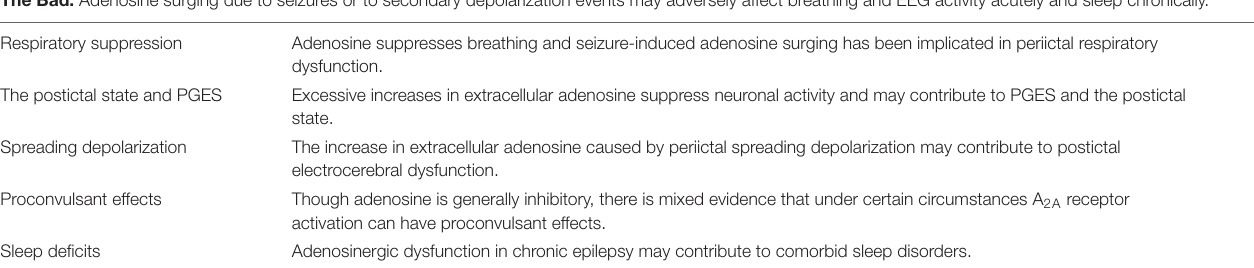
TABLE 2 | The potentially harmful effects of adenosine in the context of seizures and epilepsy. The Bad: Adenosine surging due to seizures or to secondary depolarization events may adversely affect breathing and EEG activity acutely and sleep chronically. Respiratory suppression The postictal state and